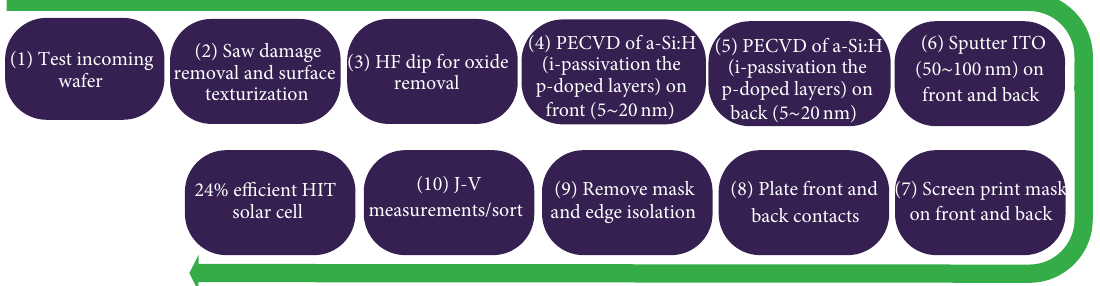
Figure 8: Model fabrication process flow for bifacial technology HIT solar cell